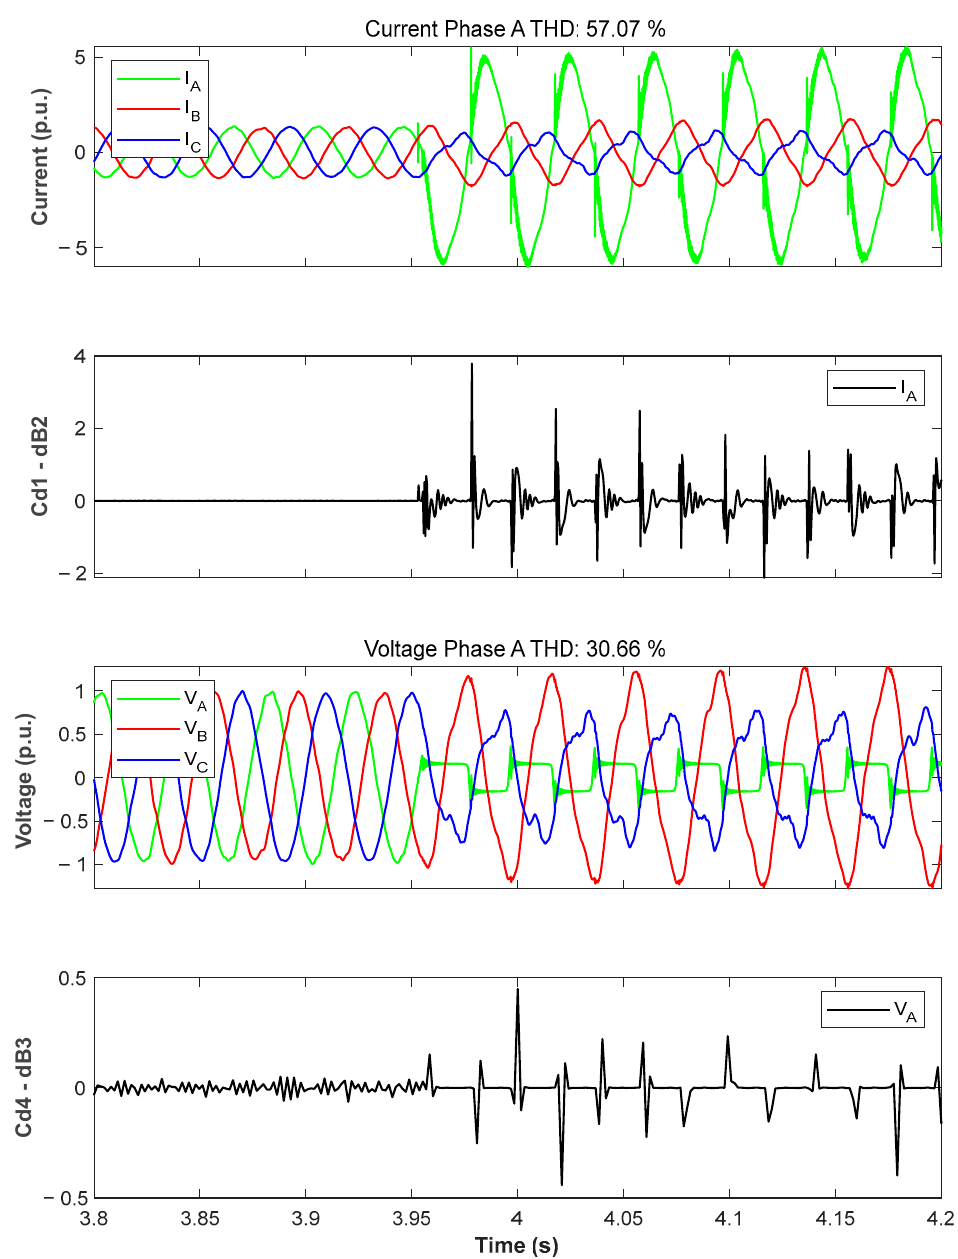
Figure 6. Three-phase currents and voltages and the Wavelet coefficients for the current and voltage in phase A during a phase-to-ground arc fault at the fault location (i.e., on the load side).